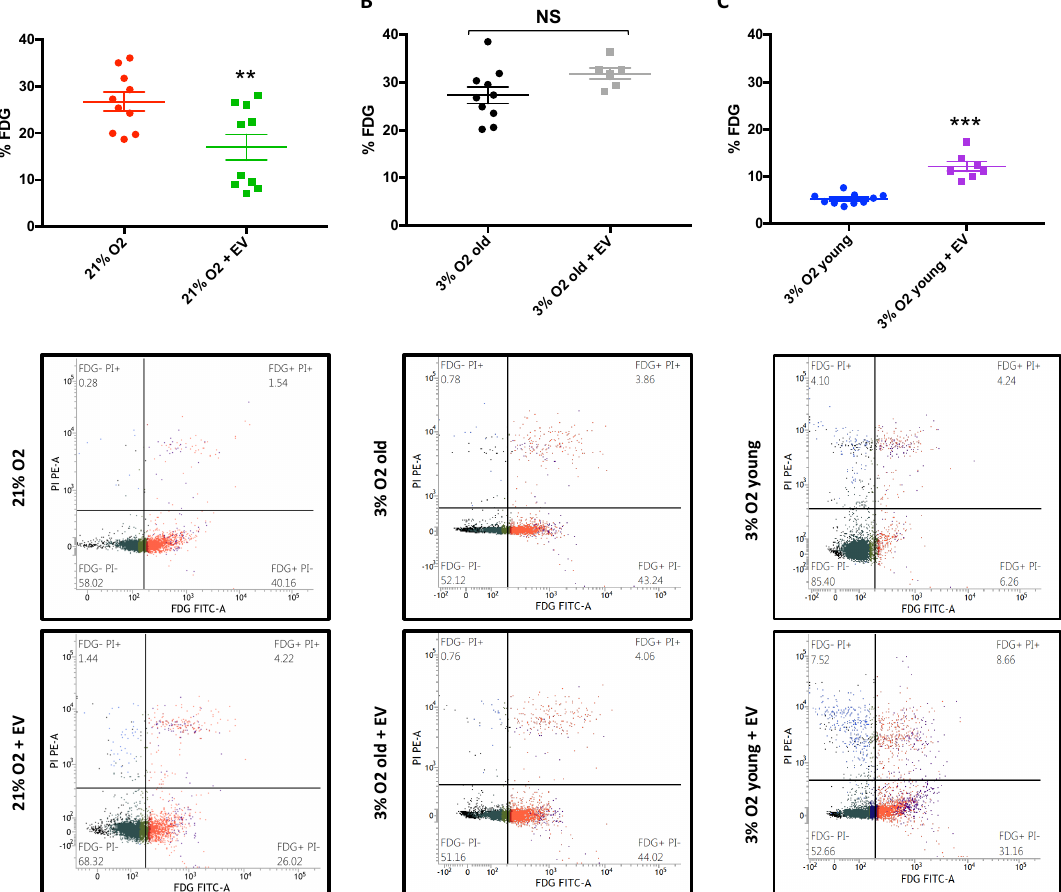
Figure 2. EVs can modulate premature senescence at 21% oxygen. SA- β -galactosidase activity in ( A ) young hDPSCs at passage 5, cultured at 21% O 2 with or without 48 h incubation with EVs derived from young hDPSCs at passage 5, cultured at 3% O 2 ( n CTL = 10 and n EV = 10), ( B ) old hDPSC at passage 25, cultured at 3% O 2 with or without 48 h incubation with EVs derived from young hDPSCs at passage 5, cultured at 3% O 2 ( n CTL = 10 and n EV = 6) and ( C ) young hDPSCs at passage 5, cultured at 3% O 2 with or without 48 h incubation with EVs derived from young hDPSCs at passage 5, cultured at 21% O 2 ( n CTL = 10 and n EV = 6). The data are shown as means ± SD. Statistical significance is expressed as ** p < 0.01 and *** p < 0.001. NS means no